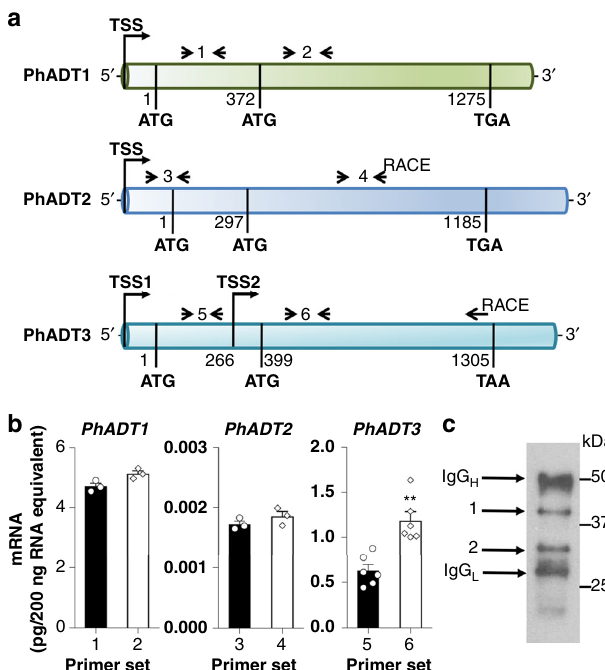
Fig. 5 Alternative PhADT3 transcript yields a cytosolic isoform in petunia fl owers. a Schematic presentation of PhADT1 , PhADT2, and PhADT3 mRNA and positions of gene-speci fi c primer sets shown in Supplementary Table